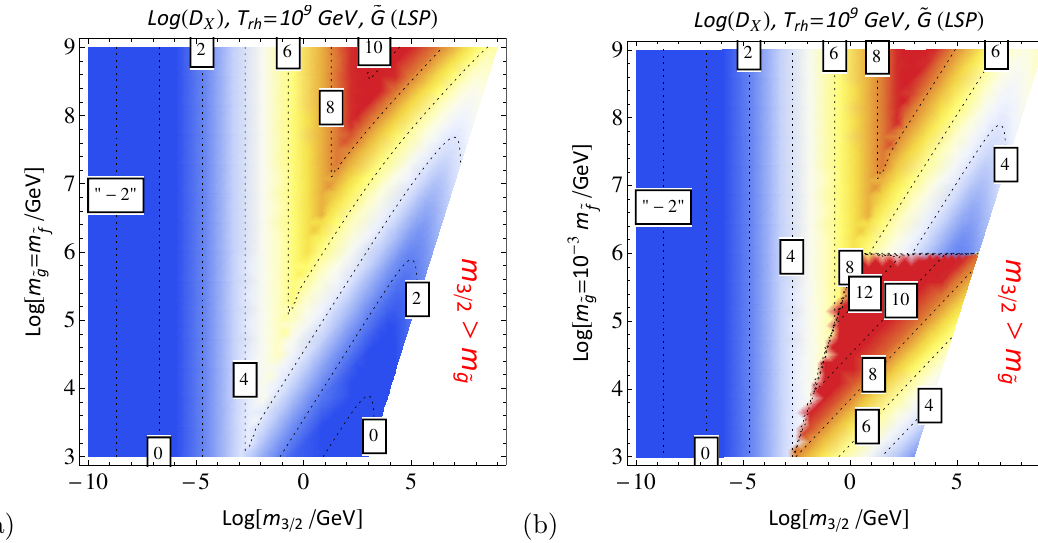
Figure 2 . Density and contour plot of the decadic logarithm of the required dilution for T rh = 10 9 GeV reheating temperature after in(cid:13)ation and gravitno the stable LSP. In the left panel degenerate spectrum for the sfermions and gauginos was considered, m ~ = m ~ g , while in the right f panel there is a split spectrum with m ~ = 10 3 m ~ g . Thermal production of helicity (cid:6) 3 = 2 and (cid:6) 1 = 2 f gravitinos from scatterings in the plasma, non-thermal production from decays of sfermions and the NLSP to helicity (cid:6) 1 = 2 gravitinos have been taken into account. The contributions to the gravitino abundance have been conditionally added, i.e. in the parts of the contour that thermal equilibrium is achieved the total abundance is replaced by the thermal one. The magnitude of the logarithm of the required dilution is given by the contour numbers onto the density plot. Negative numbers correspond to underabundance, hence to no dilution contour